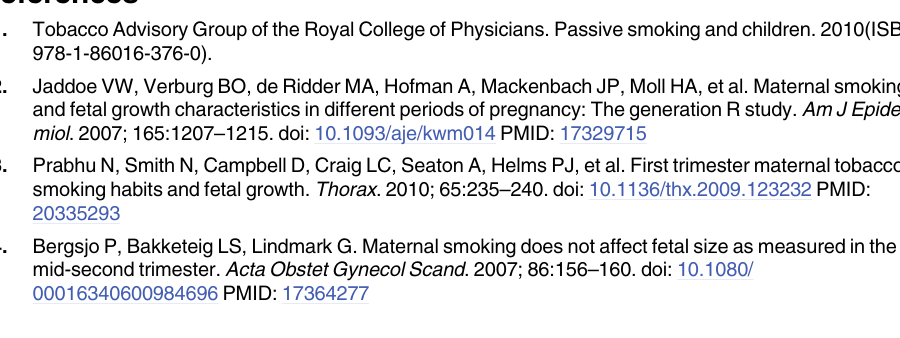
S2 Fig. Forest plots showing differences in standardised second trimester measurements between individuals whose mothers smoked and did not smoke. S3 Fig. Forest plots showing differences in absolute second trimester measurements between individuals whose mothers smoked and did not smoke. S4 Fig. Funnel plots for standardised second trimester measurements between individuals whose mothers smoked and did not smoke. S5 Fig. Forest plots showing differences in standardised third trimester measurements between individuals whose mothers smoked and did not smoke. S6 Fig. Forest plots showing differences in absolute third trimester measurements between individuals whose mothers smoked and did not